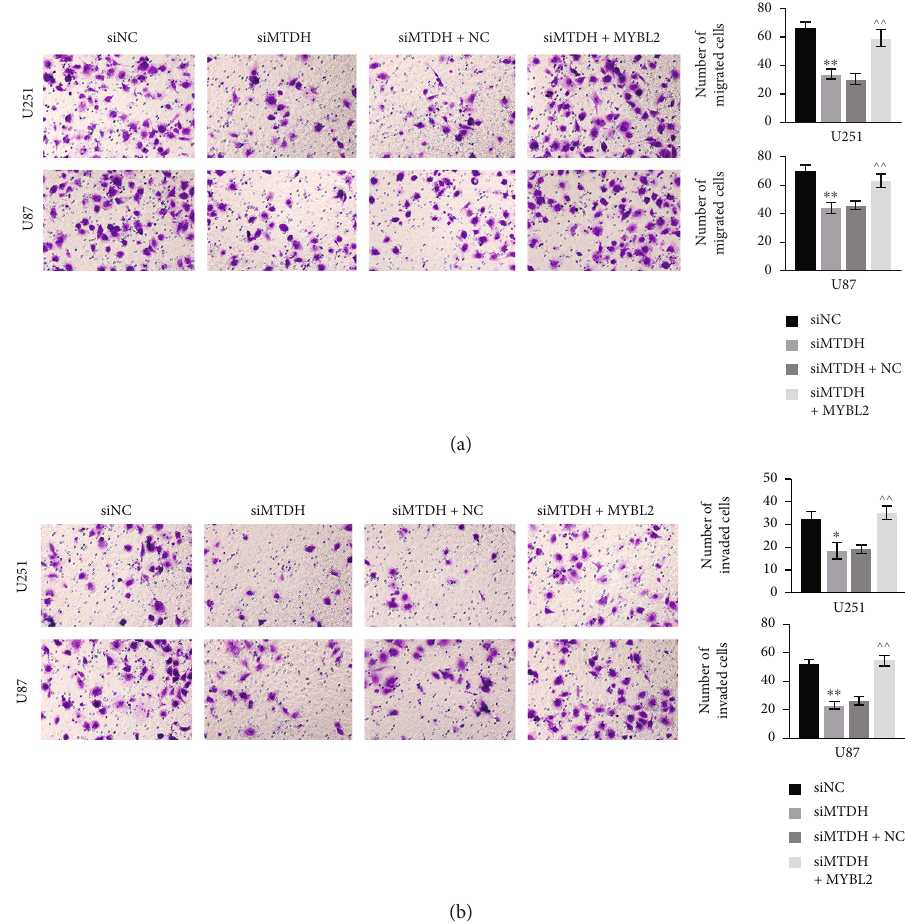
Figure 4: Cell migration and invasion in four groups, siNC, siMTDH, siMTDH+NC, and siMTDH+MYBL2, observed under the microscope in U251 and U87 cell lines (a). The cell migration in the four groups was observed under the microscope and the statistics of the calculated number of migrated cells (b). The cell invasion in the four groups was observed under the microscope and the calculated number of invasive cells. N = 3 , ∗ p < 0 : 05 vs. the siNC group; ∗∗ p < 0 : 01 vs. the siNC group; ^^ p < 0 : 01 vs. the siMTDH+NC